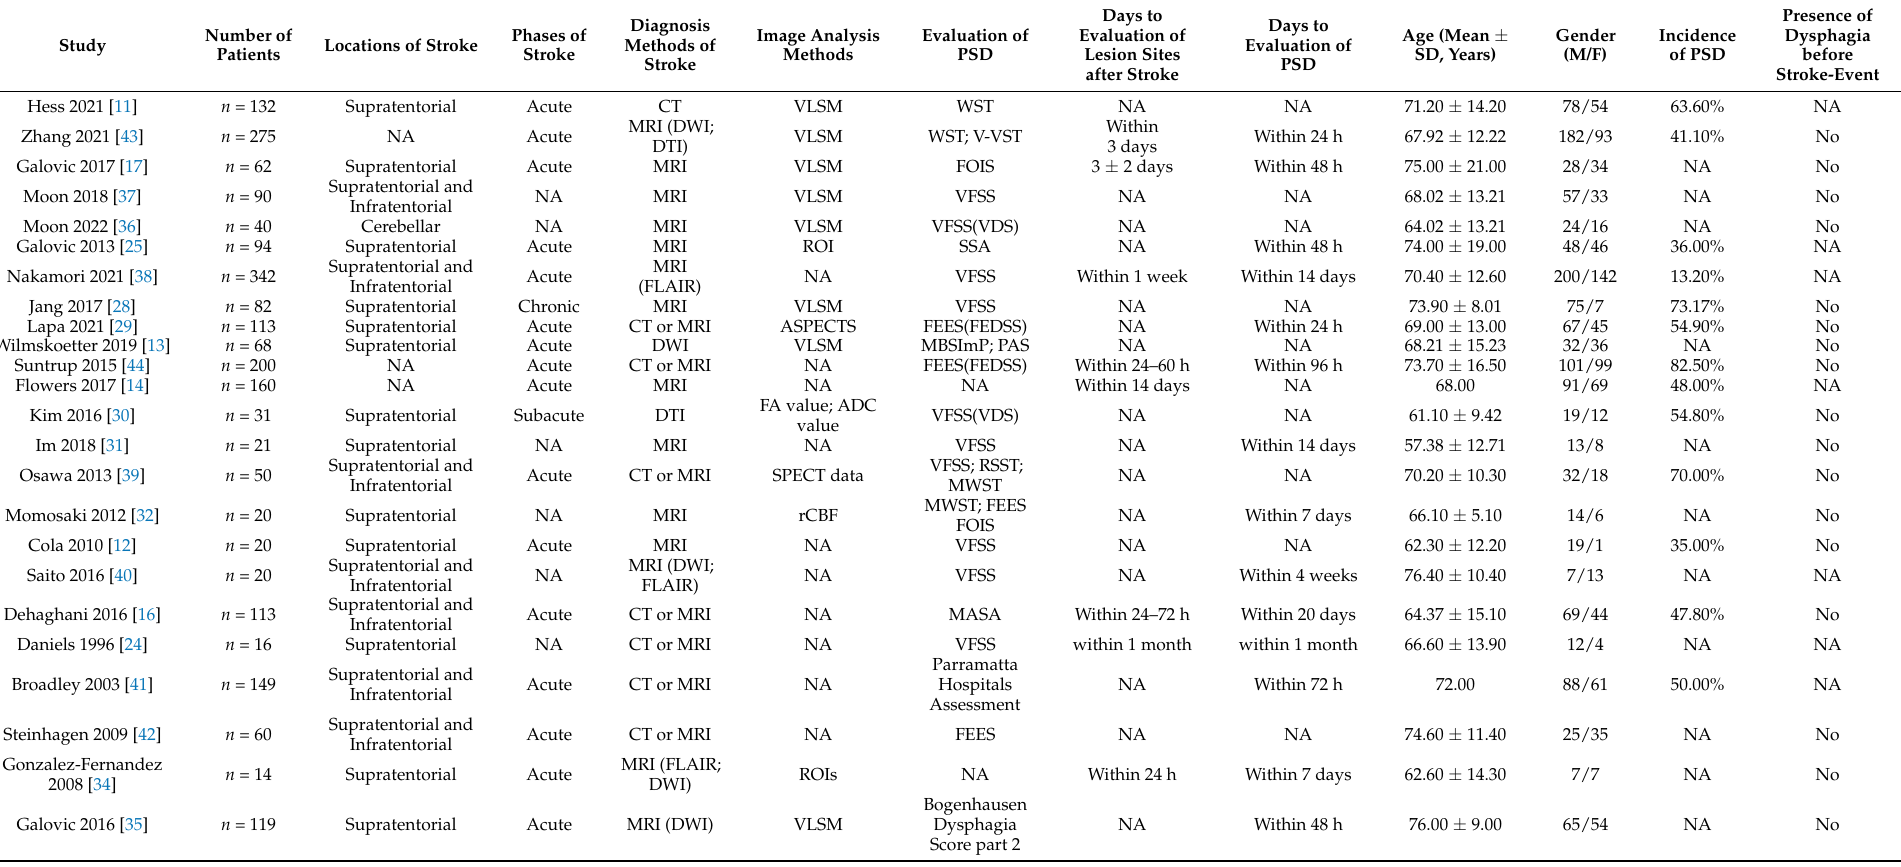
Table 1. The characteristics of included